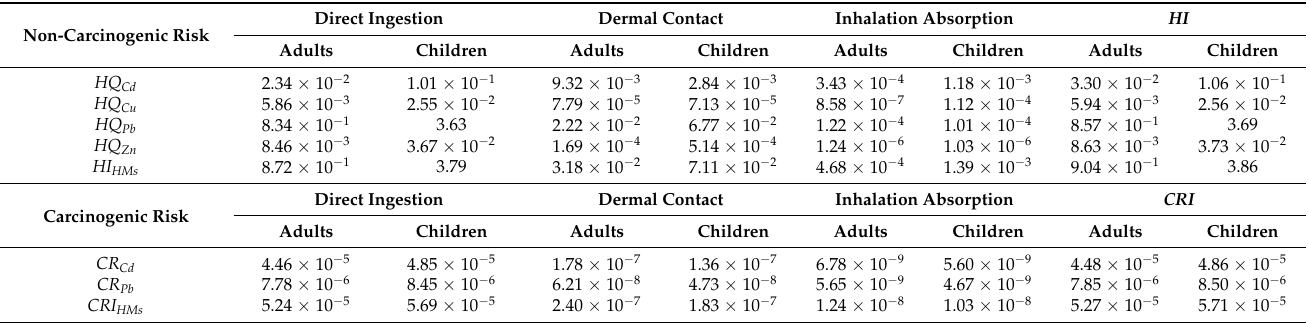
Table 7. Non-cancer and cancer risk